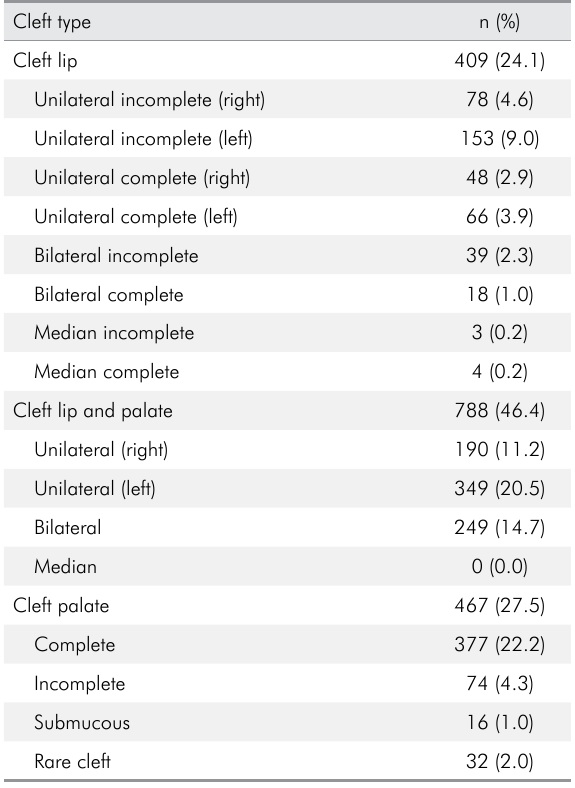
Table 3. Overall and group prevalence of the different types of oral cleft (n=